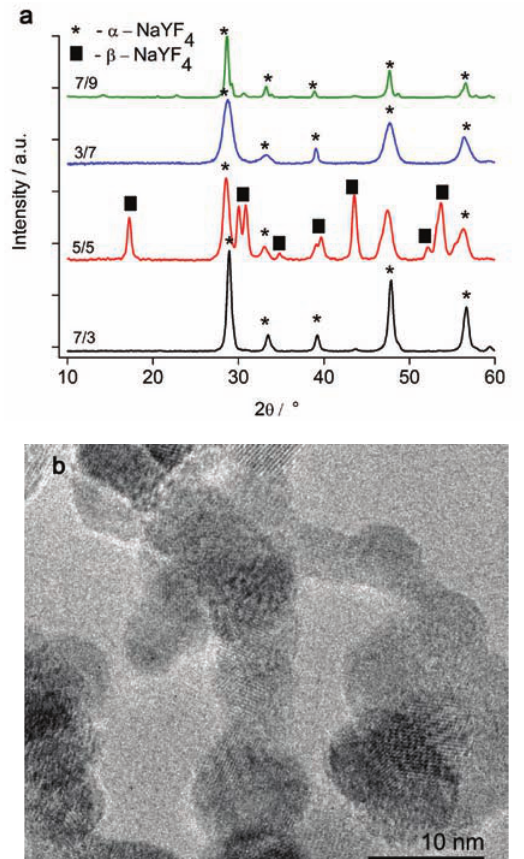
:Yb,Tm 4 :Yb,Tm nanoparticles 4